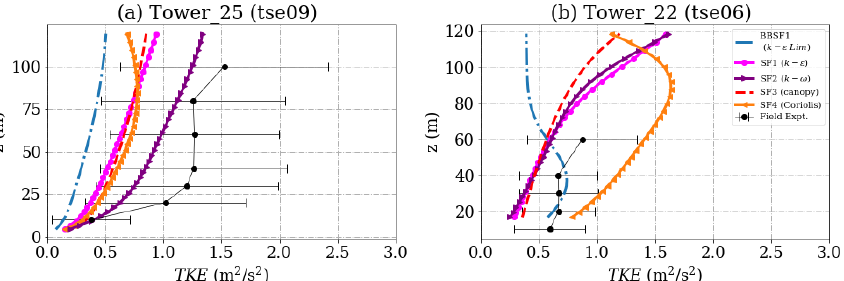
Figure 11. Simulation results and experimental data for turbulent kinetic energy inside the valley for (a) Tower 25 (tse09) and (b) Tower 22 (tse06). The locations of the masts are given in Fig. 2.